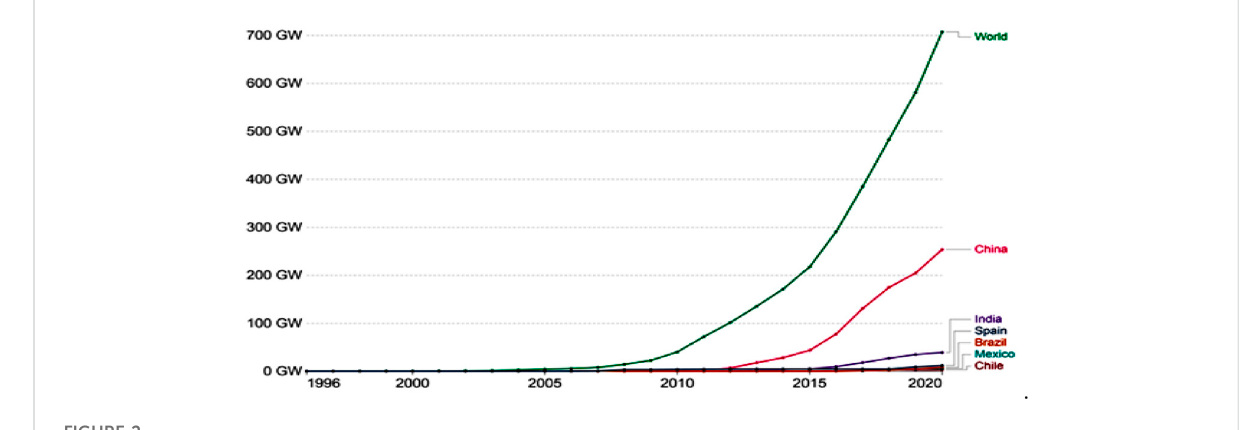
FIGURE 2 Installed solar PV capacity year wise (1996 – 2020).